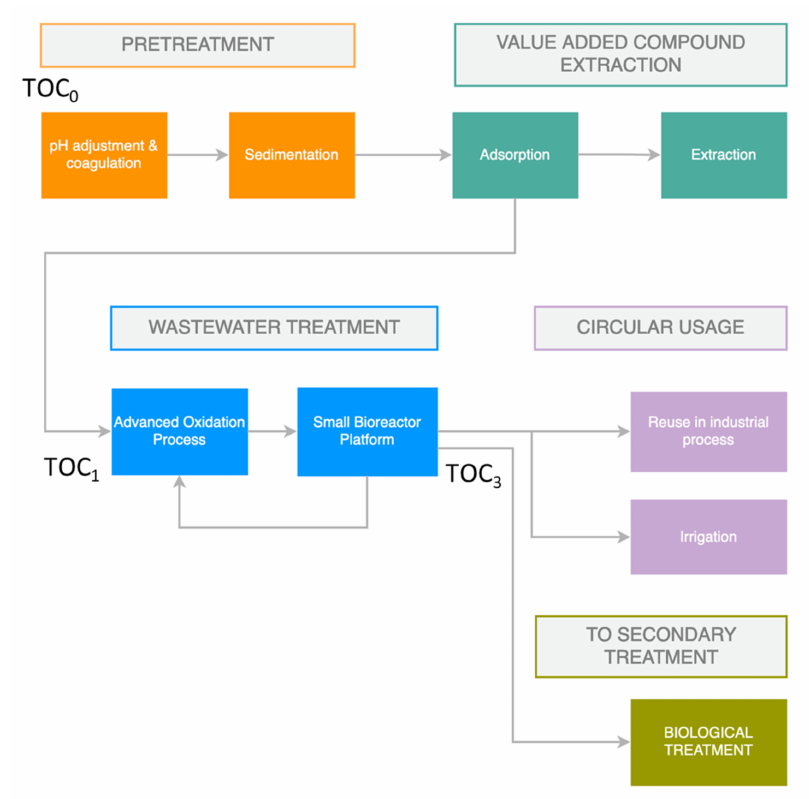
Figure 1. Diagram of the water reclamation